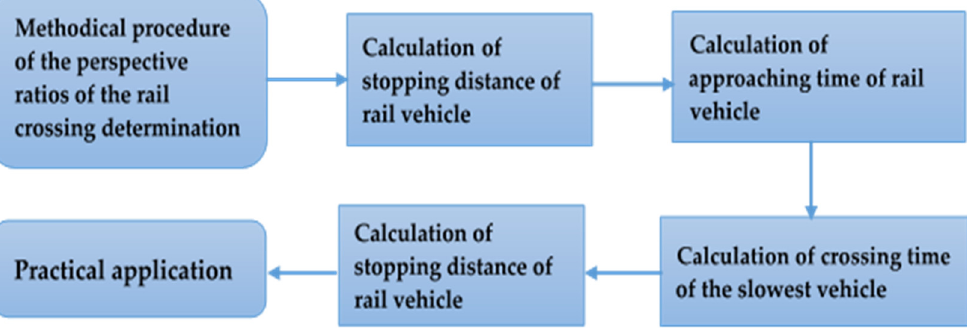
Figure 6. Methodical procedure of the perspective ratios determination .